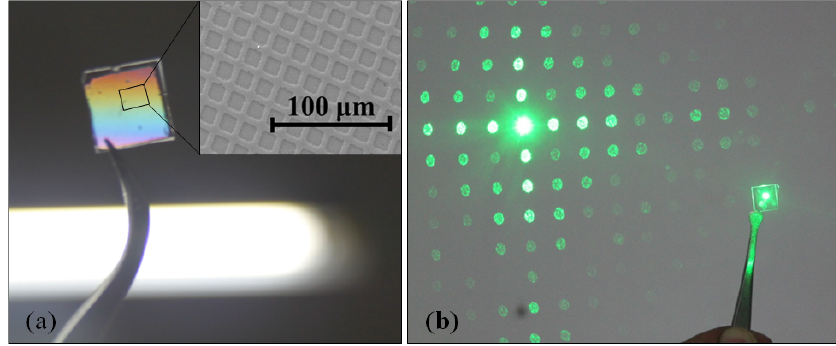
Figure 14. ( a ) TEM etched glass; ( b ) Interference phenomenon by the TEM etched glass.